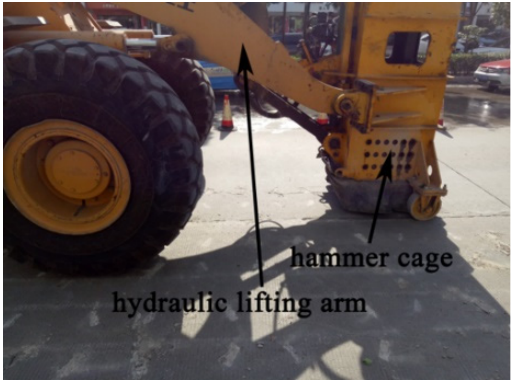
Figure 1. Micro-crack homogenization crushing of pavement structure [2].